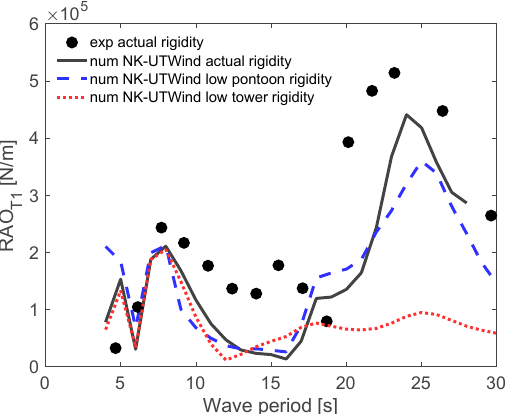
Figure 18. Influence of the tower and pontoon rigidities on the RAO tension result at the front guy wire (T1), and its comparison between the experiment and numerical calculation.